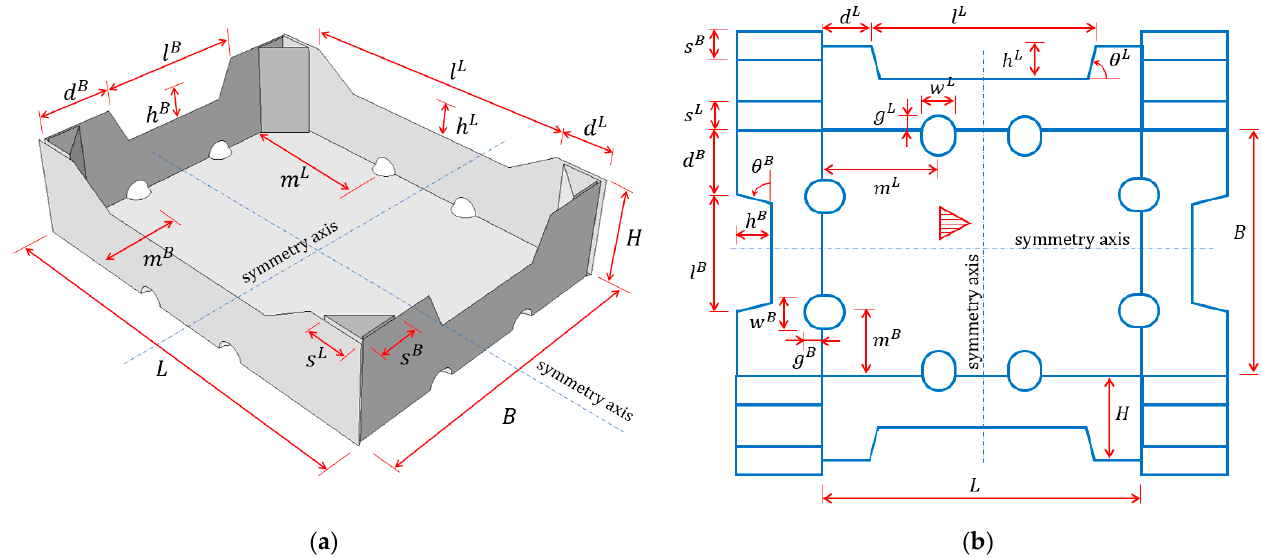
Figure 1. Parametric model of the open-top tray: ( a ) 3D view and ( b ) 2D scheme (for clarity, 𝑤 (cid:3013) , 𝑔 (cid:3013) , 𝑤 (cid:3003) , 𝑔 (cid:3003) , 𝜃 (cid:3013) , and 𝜃 (cid:3003) parameters are not shown in the first drawing).